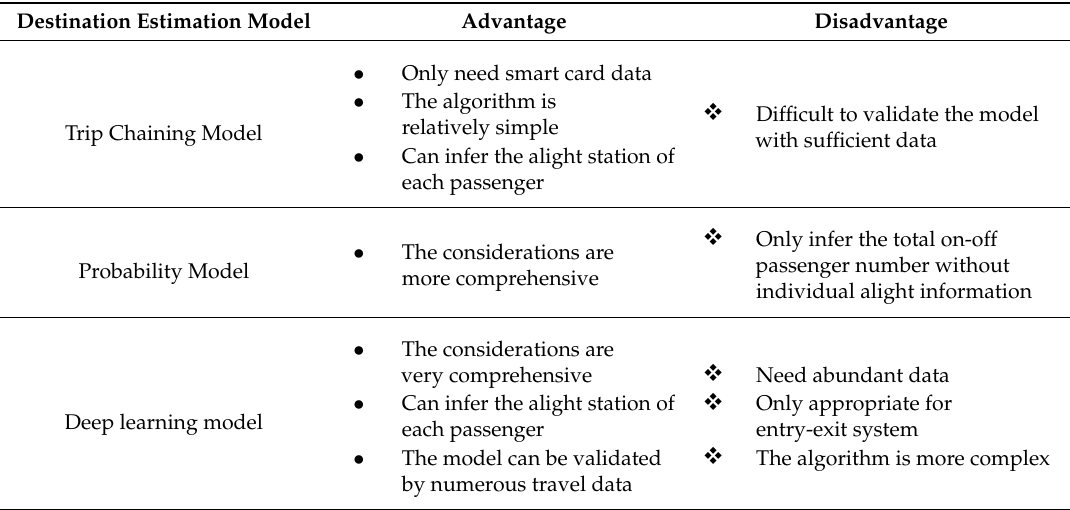
Table 4. Overall structure of deep learning model.